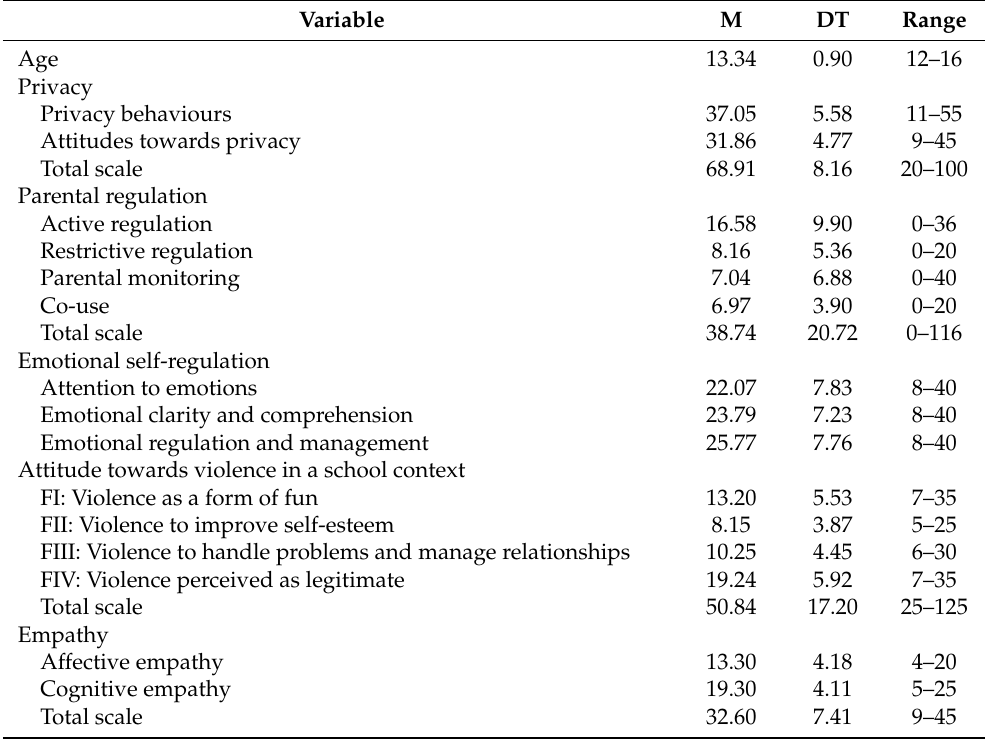
Table 2. Description of the sample. Quantitative